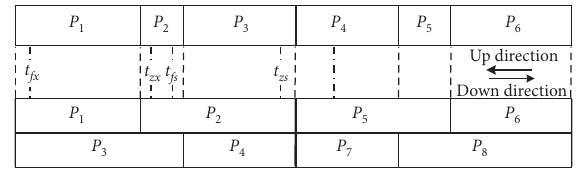
Figure 1: The control logic of the overlapping